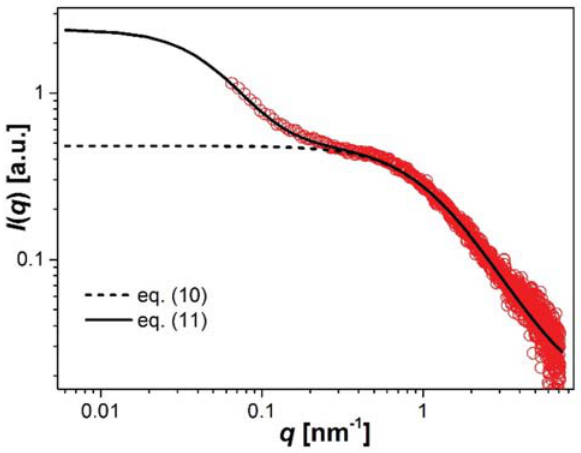
Figure 2: The resulting fits of Equation (10) (dashed line) and Equation (11) (solid line) to the experimental SAXS data of 2 wt. % KC aqueous solution at 55 °C.